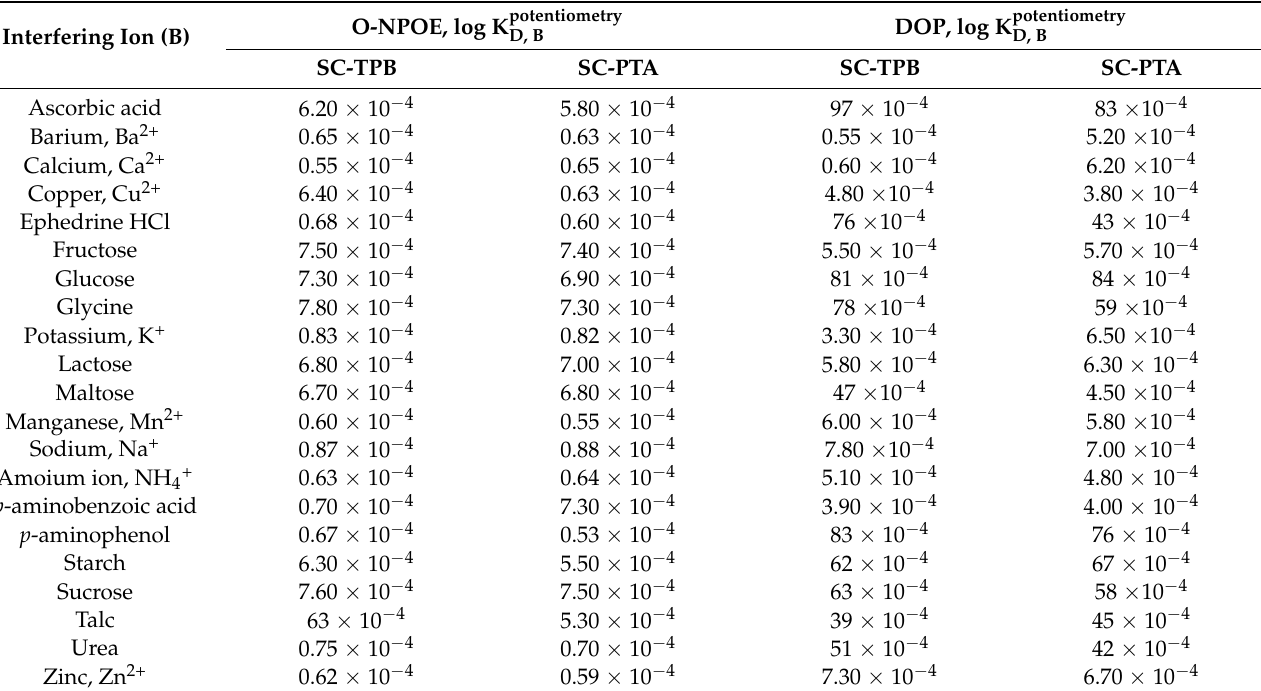
Table 2. Selectivity coefficients of various interfering species for SC-TPB and SC-PTA.